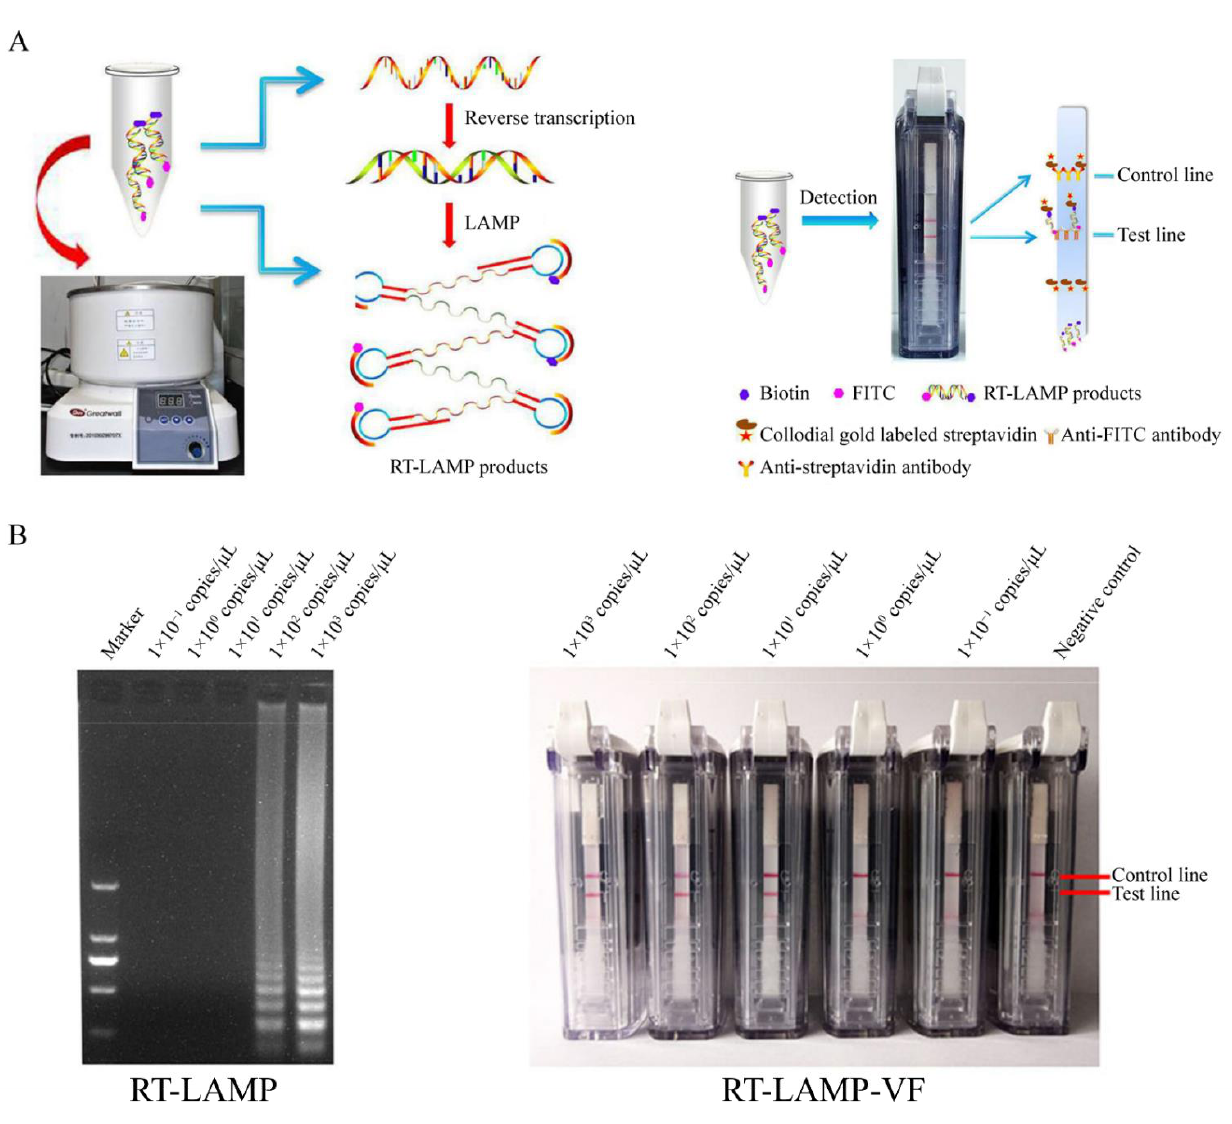
Figure 1. LAMP assay for MERS-CoV detection. ( A ) Schematic of the RT-LAMP with RT-LAMP-VF; ( B ) Comparison of sensitivity between conventional RT-LAMP and RT-LAMP-VF (reproduced with permission [45]. Copyright 2018, Frontiers). RT-LAMP: reverse transcription loop-mediated isothermal amplification; RT-LAMP-VF: RT-LAMP with a vertical flow visualization strip.